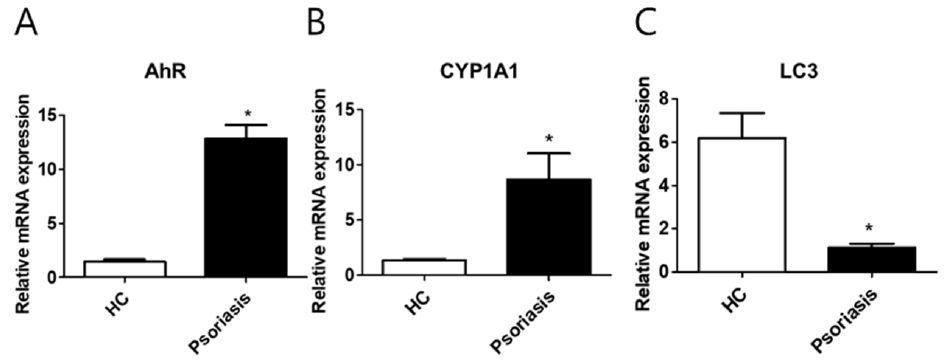
Figure 8. AhR, CYP1A1, and LC3 mRNA expression in psoriatic lesional skins. ( A–C ) qPCR analysis of CYP1A1, AhR, and LC3 expression in human psoriasis lesion ( n = 3) and healthy control (HC) tissues ( n = 3). Data represent the mean ± S.D. of three independent experiments (each performed in duplicate). Statistical significance was determined by Student’s t- test. * indicates p < 0.05 in comparison to unstimulated cells.